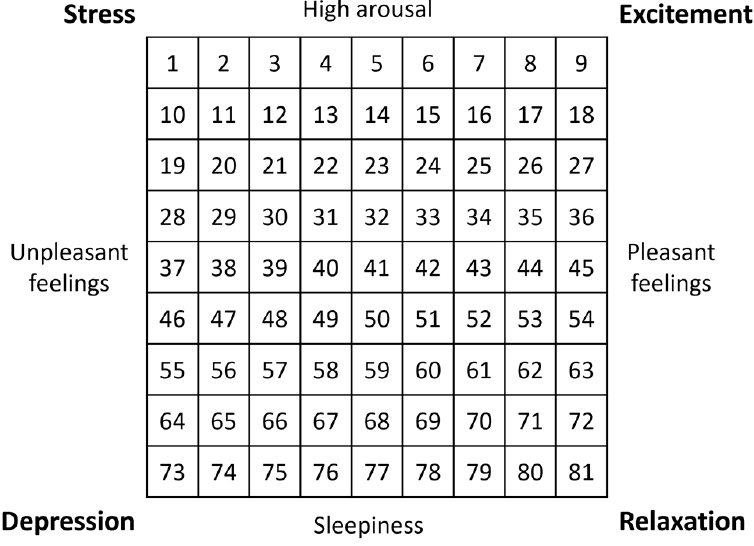
Figure 3. The matrix employed in the Affect Grid questionnaire to indicate the participant’s affective state using two dimensions (pleasantness and arousal).